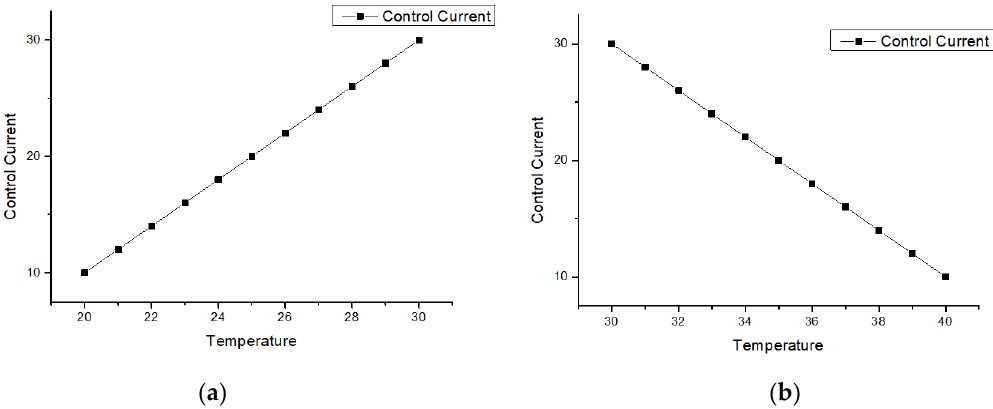
Figure 7. Charging Algorithm: ( a ) Control structure during charging mode; ( b ) CC – CV curve.